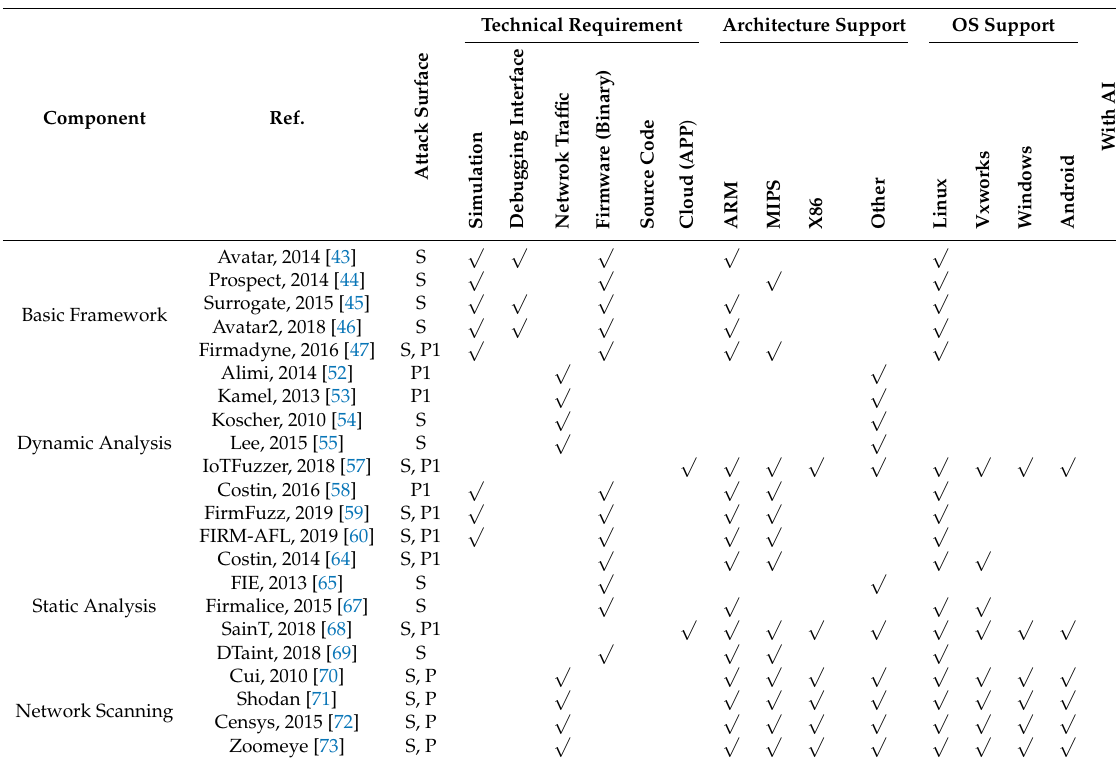
√ = Yes. S = Attack surface on software layer. P = Attack surface on protocol interface